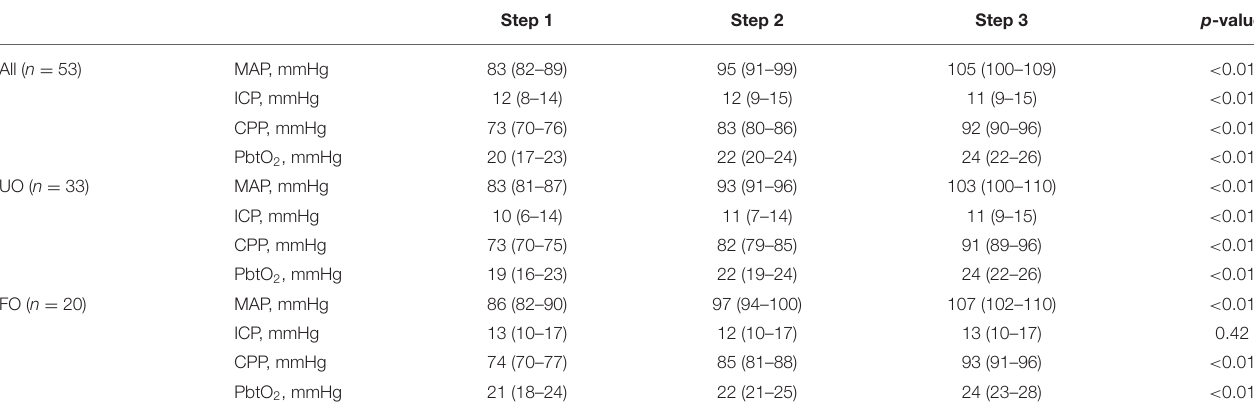
TABLE 2 | Changes in study variables on the first day of assessment, according to different steps of mean arterial pressure (MAP) and neurological outcome (UO, unfavorable; FO,